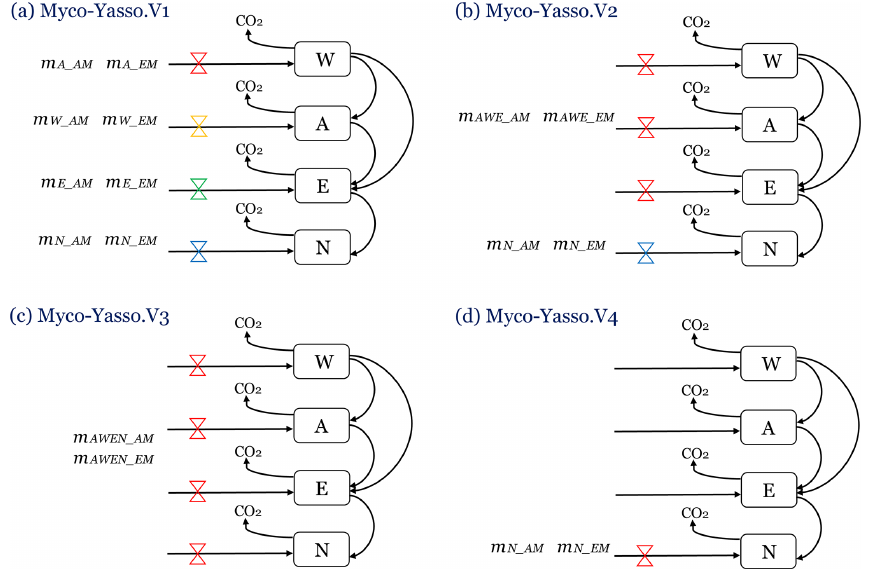
Figure 3. Four conceptualizations of the possible mechanisms of mycorrhizal impacts on litter decomposition, modelled with four versions of the Myco-Yasso model. (a) Myco-Yasso.V1: mycorrhizal impacts differ for each of the W , A , E , and N pools. (b) Myco-Yasso.V2: mycorrhizal impacts on W , A , and E pools have the same magnitude, but the mycorrhizal impact on N pool is different. (c) Myco-Yasso.V3: mycorrhizal impacts on W , A , and E pools and N pools are equal. (d) Myco-Yasso.V4: mycorrhizae impact only for the N pool. Table 1. Parameters calibrated for each model